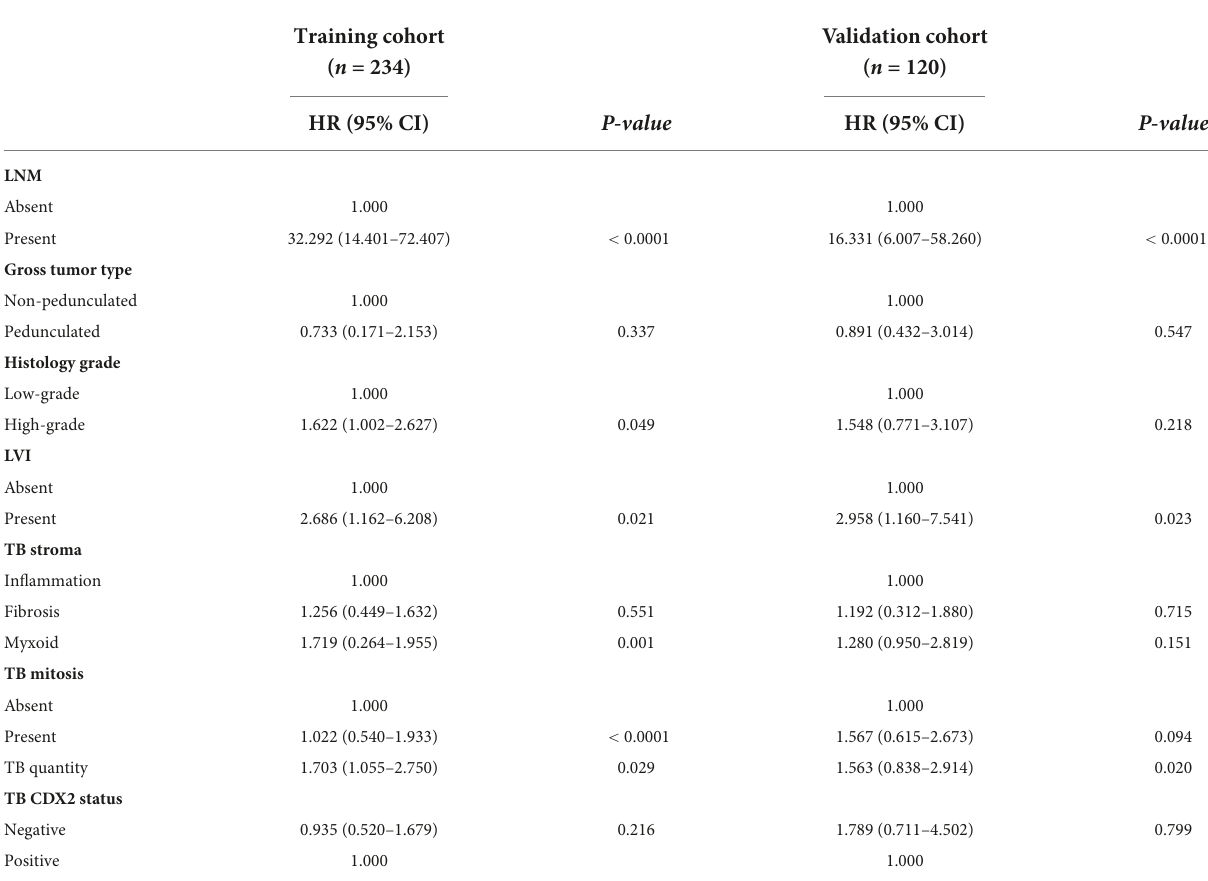
TABLE 3 Multivariate COX regression analysis of recurrence.